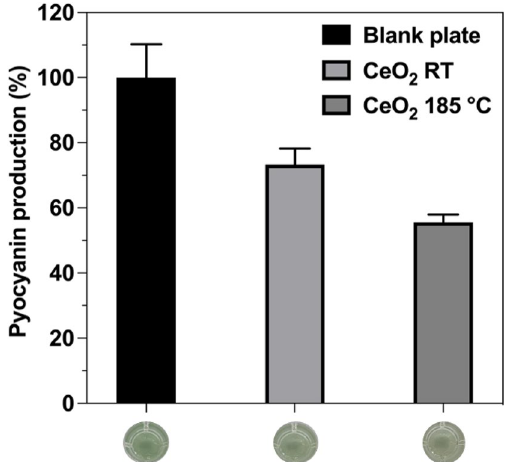
Figure 8. Effect of CeO 2 /PC nanocomposites on the pyocyanin production in P. aeruginosa PA14. The bacteria were cultivated for 72 h under shaking conditions (350 rpm) at 37 °C on non-coated and coated PC plates. The plates were then removed, and the remaining culture fluid was analyzed for pyocyanin occurrence in a plate reader at 695 nm. Error bars represent standard deviation of three independently performed